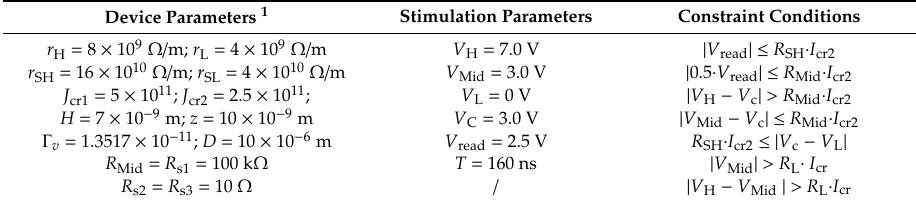
Table 5. Technical parameters for the implementation of ternary